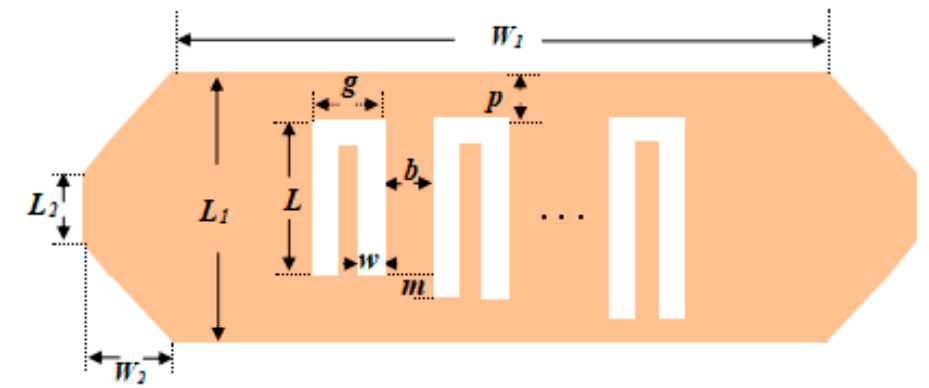
Figure 4. Electric field distribution of a single U-shaped slot resonator. U-shaped slot resonators are designed on the F4BM substrate. The relative dielectric constant, loss tangent, and substrate thickness are 2.2, 0.0007, and 1.00 mm, respectively. The High-Frequency Structure Simulator (HFSS) is used for the modeling and the simula- tion of a single U-shaped slot resonator. Figure 5 shows a schematic of the electric field distribution of a single U-shaped slot resonator. The electric field is strongest near the U-shaped slot, indicating that the U-shaped slot has